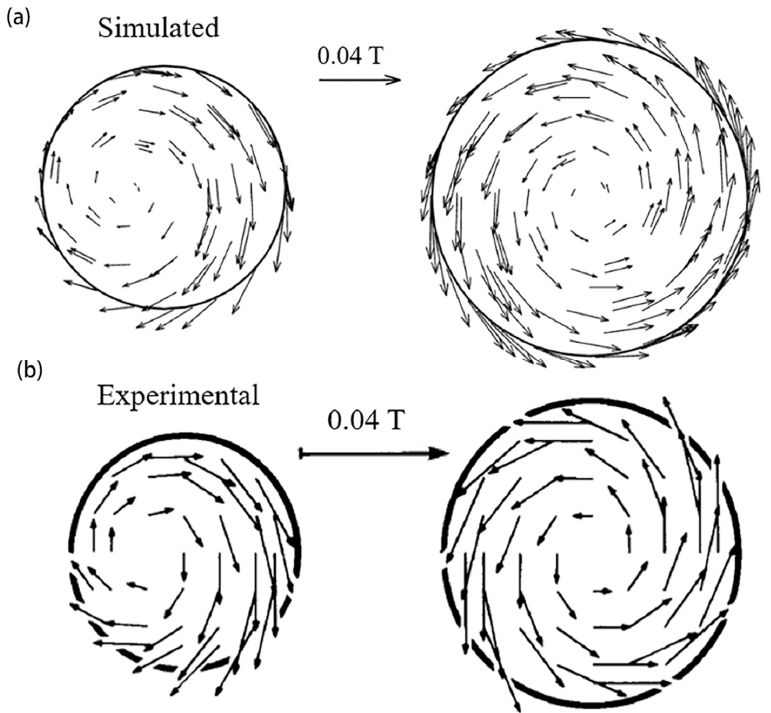
Figure 7. Numerical simulation and reference measurement results of magnetic field distribution on Z = − 20 cm channel section: ( a ) left channel; ( b ) middle channel. Reprinted with permission from ref. [36]. Copyright 1991 Springer Nature.